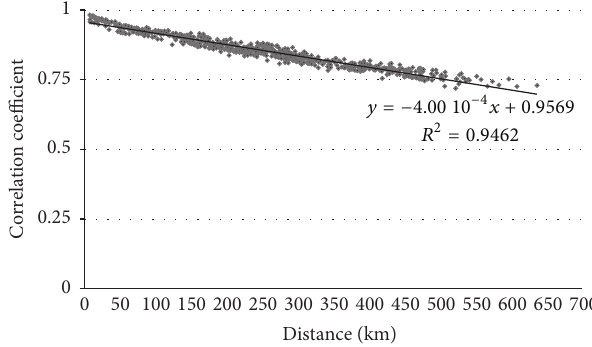
Figure 3: Values of correlation coefficients between irradiation time series (2010–2014 with a 15-minute time step); the uncertainty of the slope parameter is − 0.88% whereas that of the intercept parameter is 0.11%.